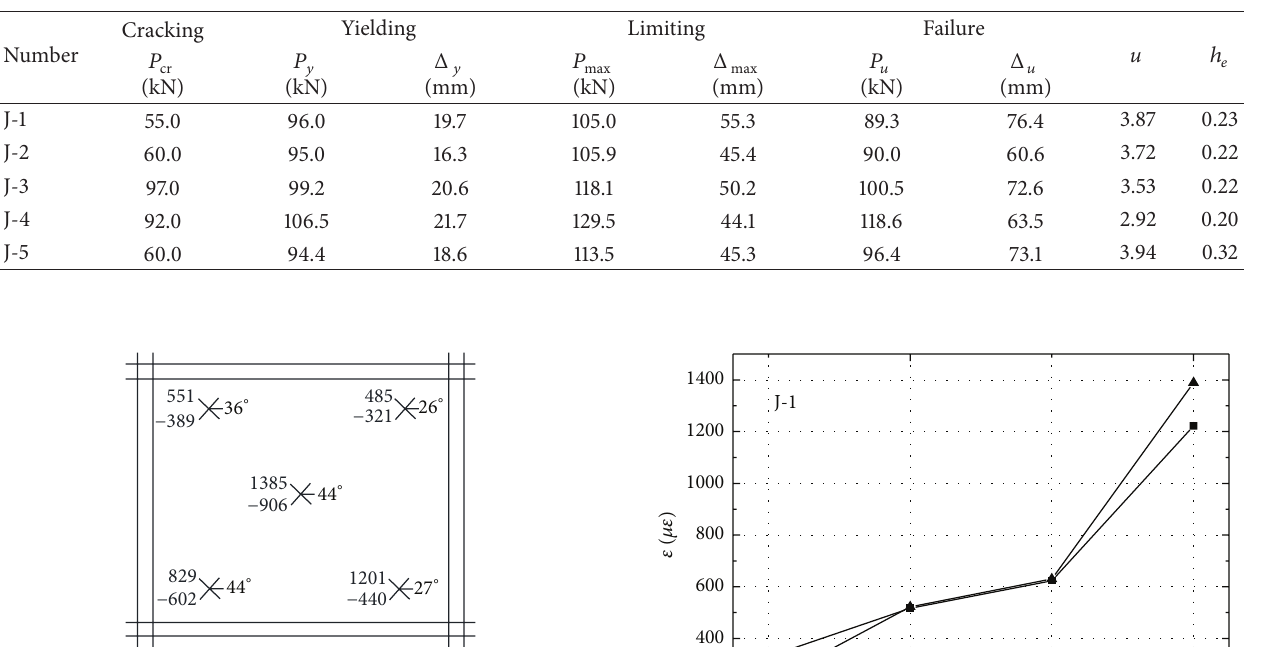
Table 5: Characteristic value at yielding, limiting, and failure condition.